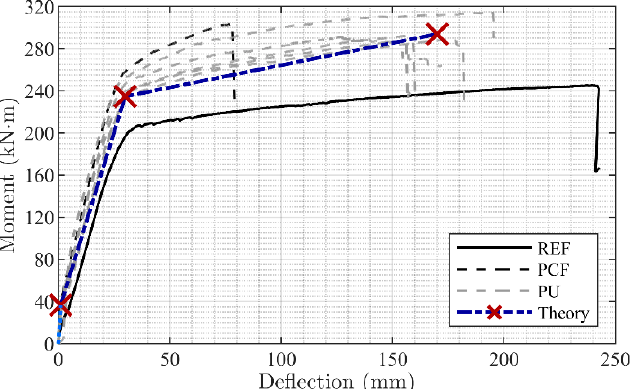
Figure 2. Strengthening effect of using the ductile CFRP strengthening system [44].